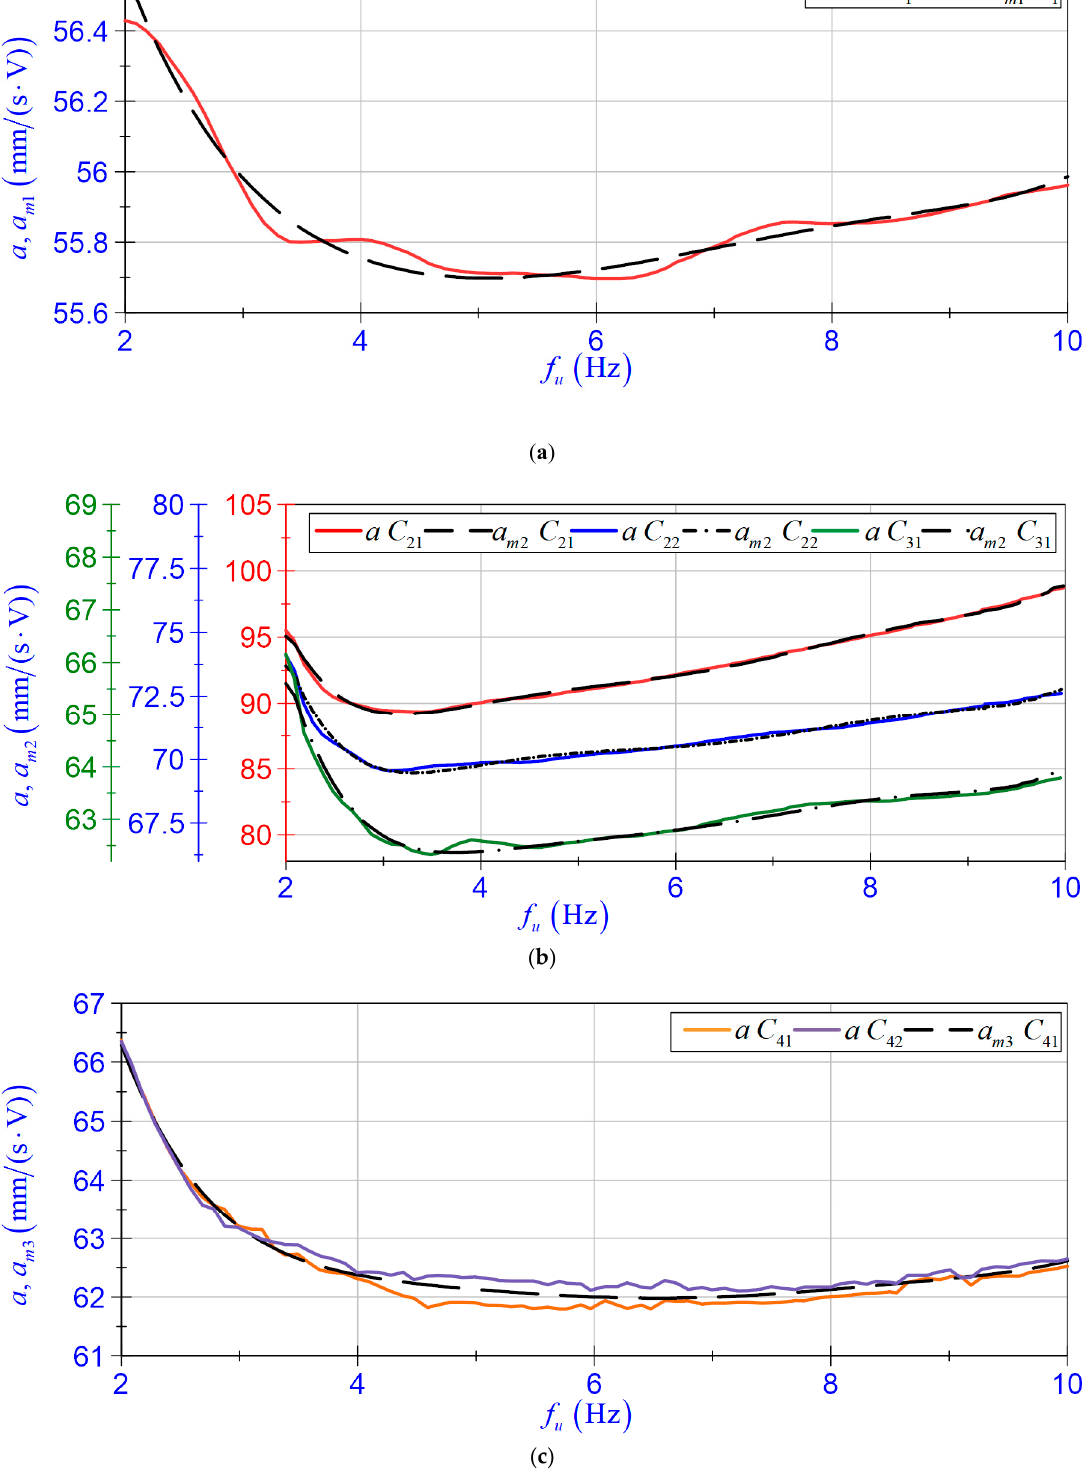
Figure 12. Gain coefficients 𝑎 and 𝑎 (cid:3040) vs. frequency 𝑓 (cid:3048) for ( a ) 𝐶 (cid:2869) ; ( b ) 𝐶 (cid:2870)(cid:2869) , 𝐶 (cid:2870)(cid:2870) , 𝐶 (cid:2871)(cid:2869) ; ( c ) 𝐶 (cid:2872)(cid:2869) , 𝐶 (cid:2872)(cid:2870) . Polynomials 𝑎 (cid:3040)(cid:2869) , 𝑎 (cid:3040)(cid:2870) , and 𝑎 (cid:3040)(cid:2871) correctly describe the changes of gain 𝑎 ; therefore, the self-sensing function expressed in Equation (2) can be re-written as: